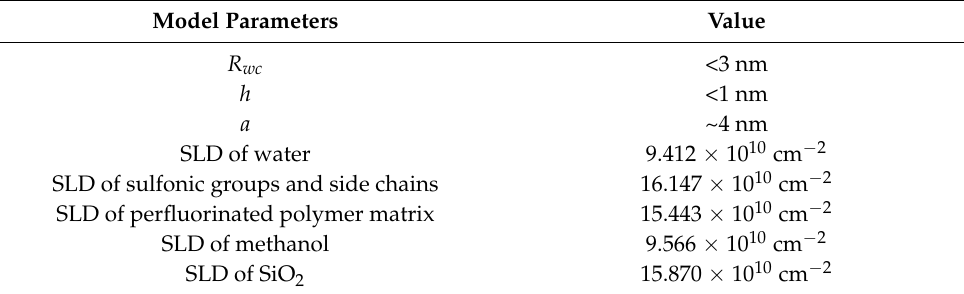
Table 1. Model parameters of the swollen Nafion ® membrane [37,38,48]. Model